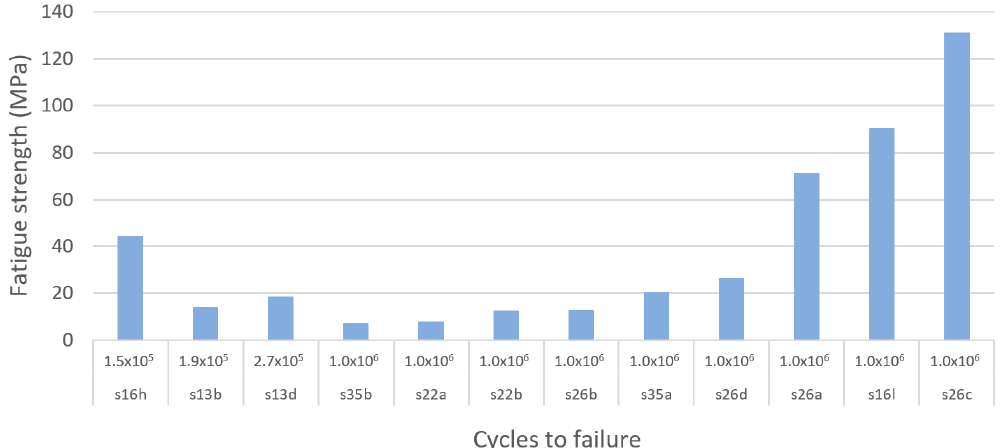
Figure 20. Comparison of the results of different studies on the fatigue strength of porous metamaterials based on triply periodic minimal surfaces (TPMS) within the high-cycle fatigue region between 10 6 and 10 7 cycles.